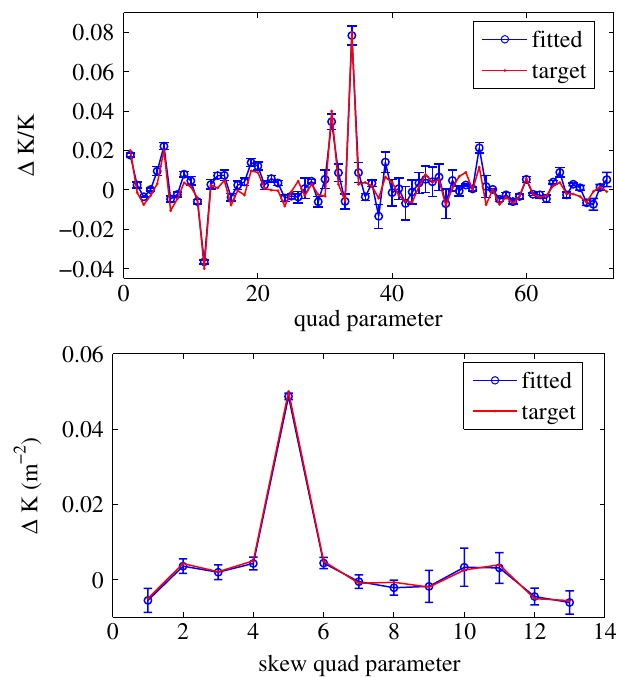
FIG. 4. The fitted quadrupole (upper) and skew quadrupole parameters (lower) are compared to the expected